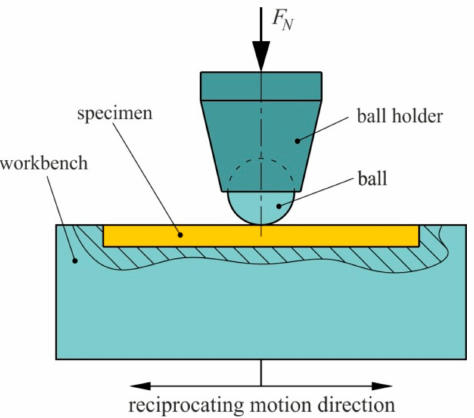
Figure 9. Schematic of UMT (Universal Mechanical Tester)-Tribolab